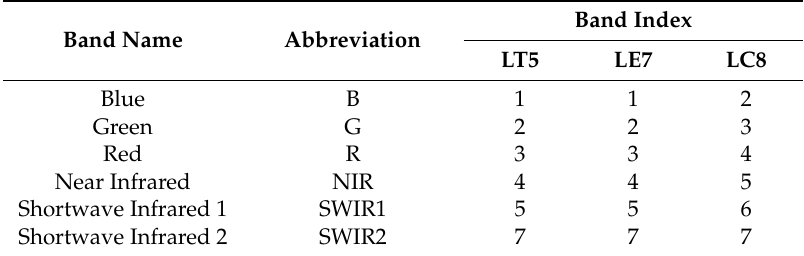
Table 2. Spectral bands from Landsat-5 (LT5), Landsat-7 (LE7), and Landsat-8 (LC8) used in this